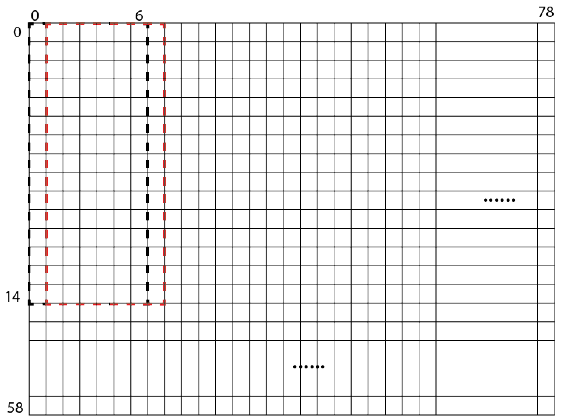
Figure 6. Sliding a 7 × 15 window over a 79 × 59 HOG frame.